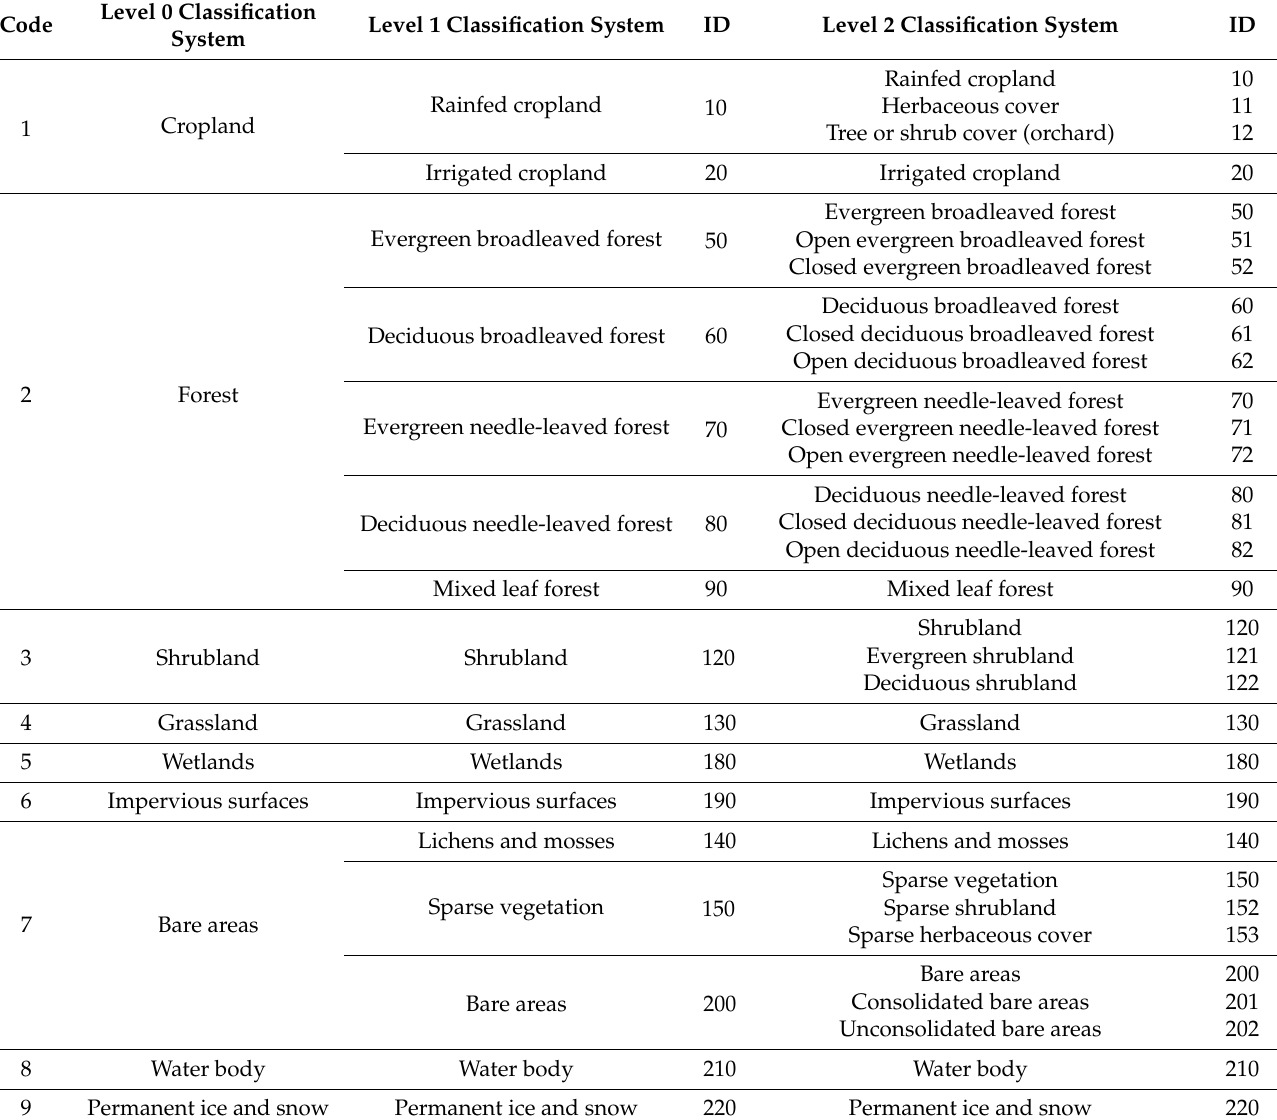
Table 1. Land use/cover classification system of